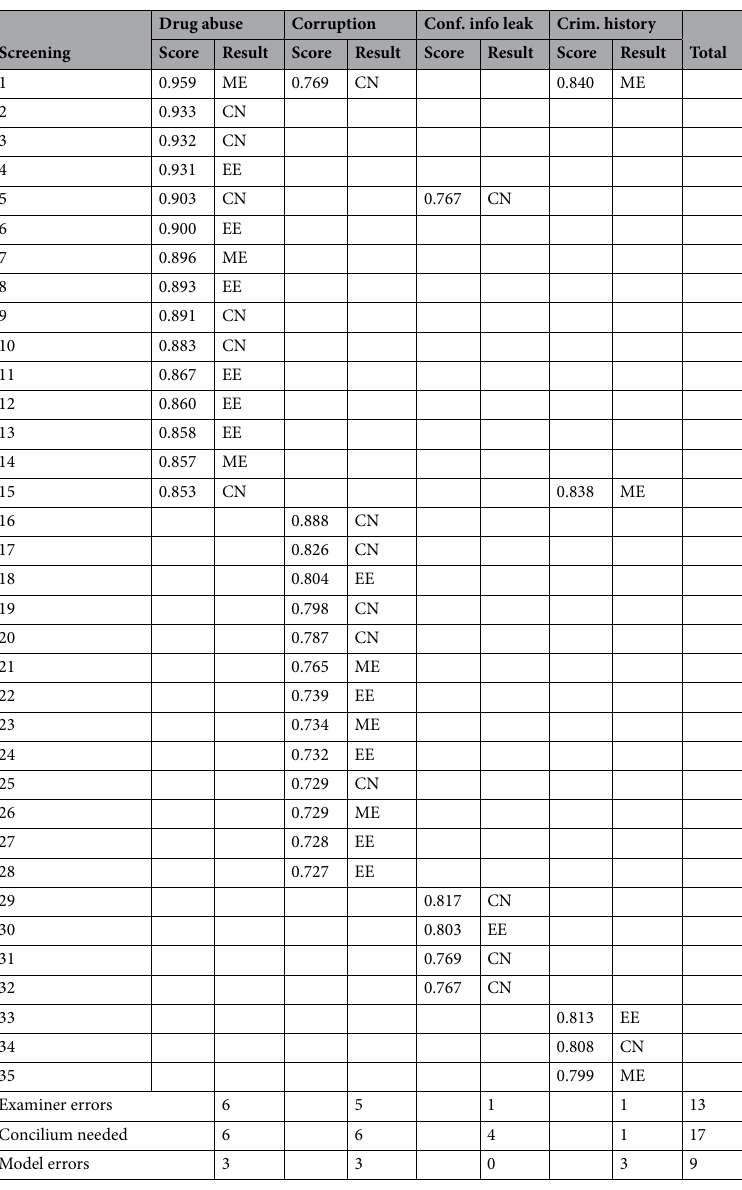
Table 9. Results of two QAs of the top candidates for examiner error (EE) in 2094 screenings. ME is model error (the suspicion in EE is disproven), CN is concilium needed (where QA1 and QA2 do not